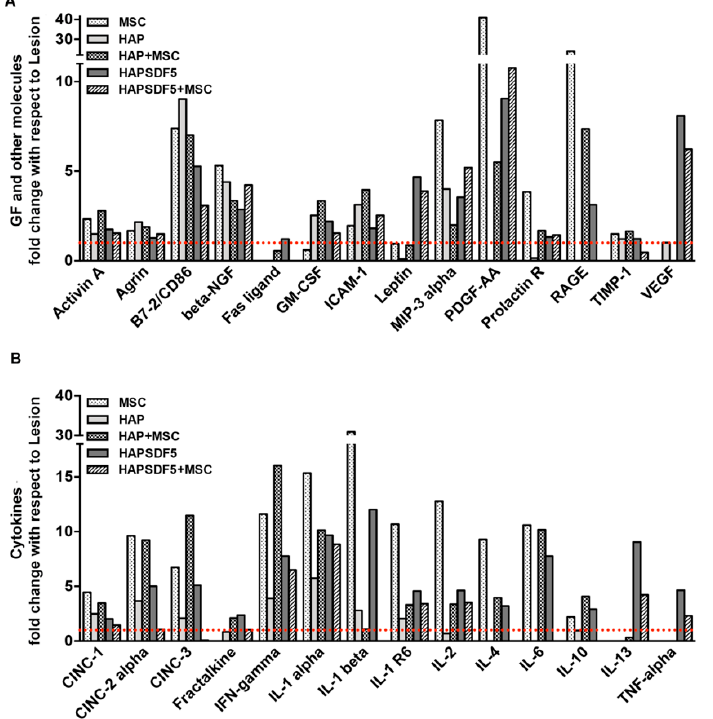
Figure 7. Plasma cytokines and growth factor profile. Semi-quantitative analysis of an array of inflammatory mediators in rat plasma expressed as fold-change with respect to the control lesion group (dashed line, y = 1). ( A ) Growth factors and other molecules; ( B ) cytokines. IFN- γ , MIP-3 α , and IL-1 β were not detected in the lesion group; for these, an arbitrary value of 1.5 was considered for the calculation of the fold-change for the remaining groups.